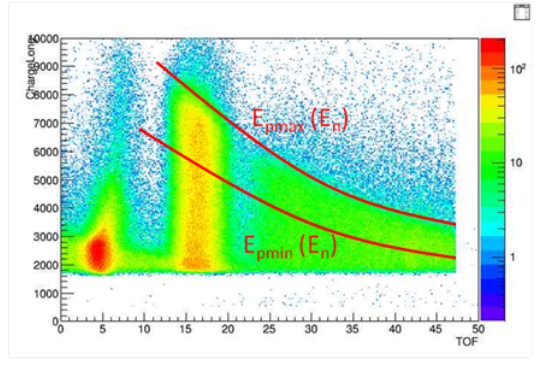
Figure 4. Scintillator pulse response vs. TOF